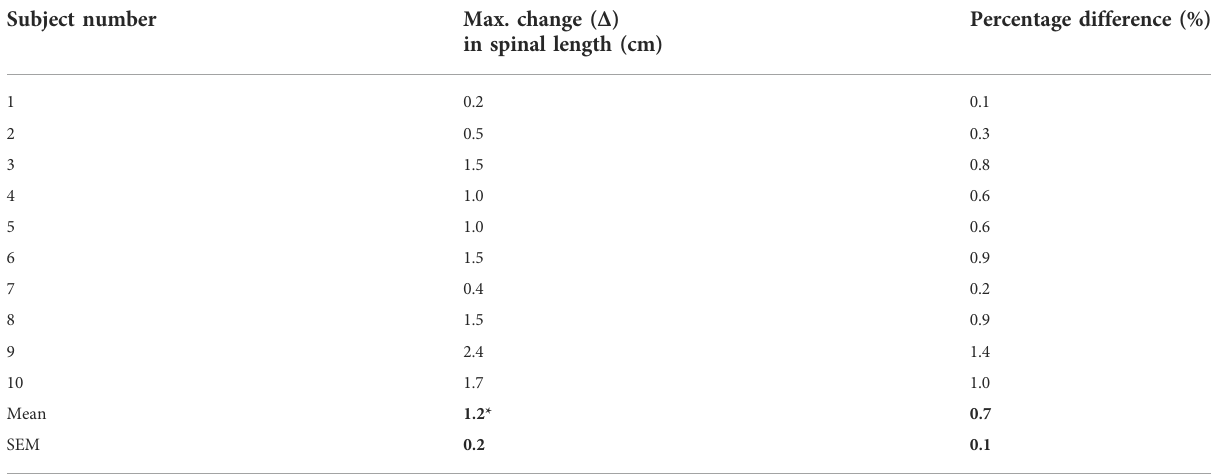
TABLE 2 Individual and mean (±SEM) ( Δ ) change in spinal length Post-Pre 6 h Dry Immersion (DI). * Indicates signi fi cant paired t -test ( p < 0.001). Max. change ( Δ